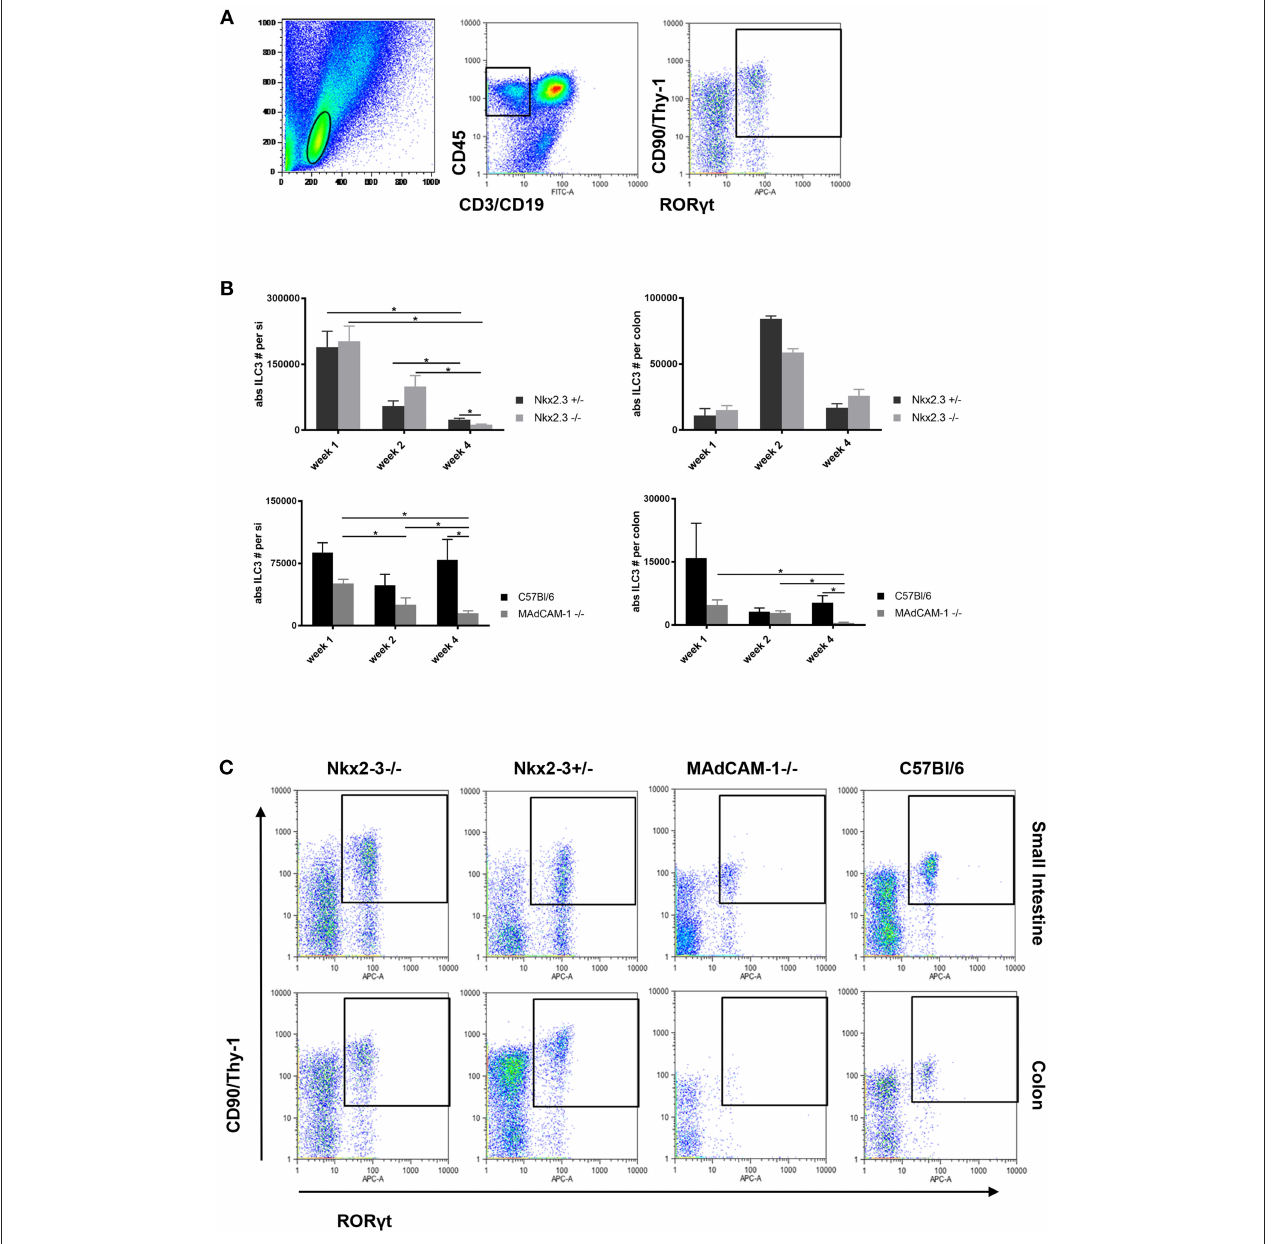
FIGURE 1 | Different distribution of ILC3 in the postnatal gut in Nkx2-3 − / − and MAdCAM-1 − / − mice. (A) Gating strategy for the identification of ILC3s defined on the basis the lymphoid gate (left: FSC/SSC ellipse) and CD45 + /non-T/B lineage (middle: rectangle) combined with CD90/ROR γ t (right, rectangle; representative example from a small intestine of a 4 weeks old C57BL/6 mouse). (B) Kinetics of the absolute number of ILC3s in Nkx2-3 − / − and Nkx2-3 + / − mice (top) and MAdCAM-1 − / − and wild-type C57BL/6 (bottom) intestine (small intestine: left, colon: right) at various ages as indicated ( n = 3–7, mean ± SEM, * p < 0.05). (C) Representative example of the appearance of ILC3s in the small intestine and colon of Nkx2-3 − / − , Nkx2-3 + / − , MAdCAM-1 − / − , and wild-type C57BL/6 mice at 4 weeks of age.